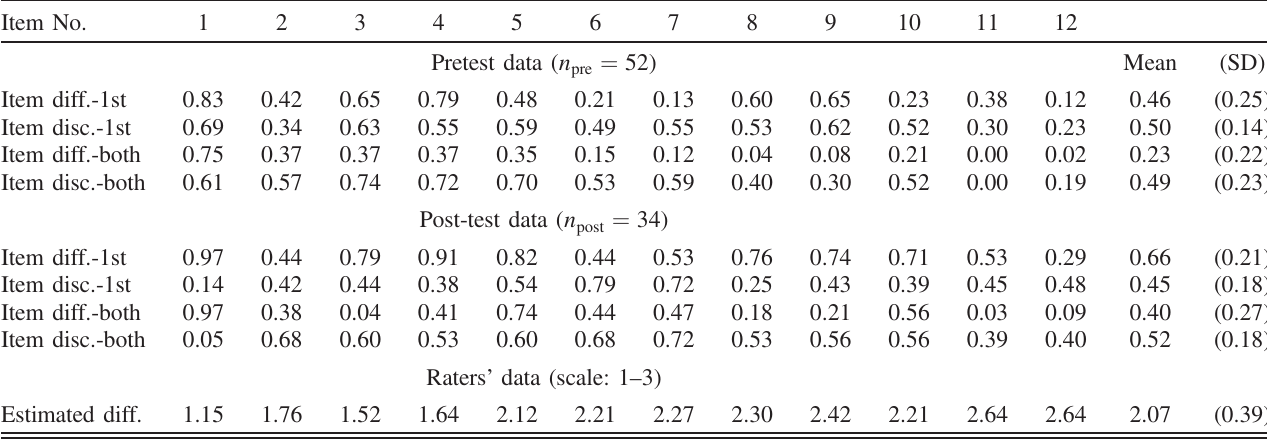
TABLE II. The FBDT item statistics: item difficulty and item discrimination indices, based on the results of the pretest and post-test survey. The raters ’ estimates of item difficulties are also given for purposes of comparison. Item No.